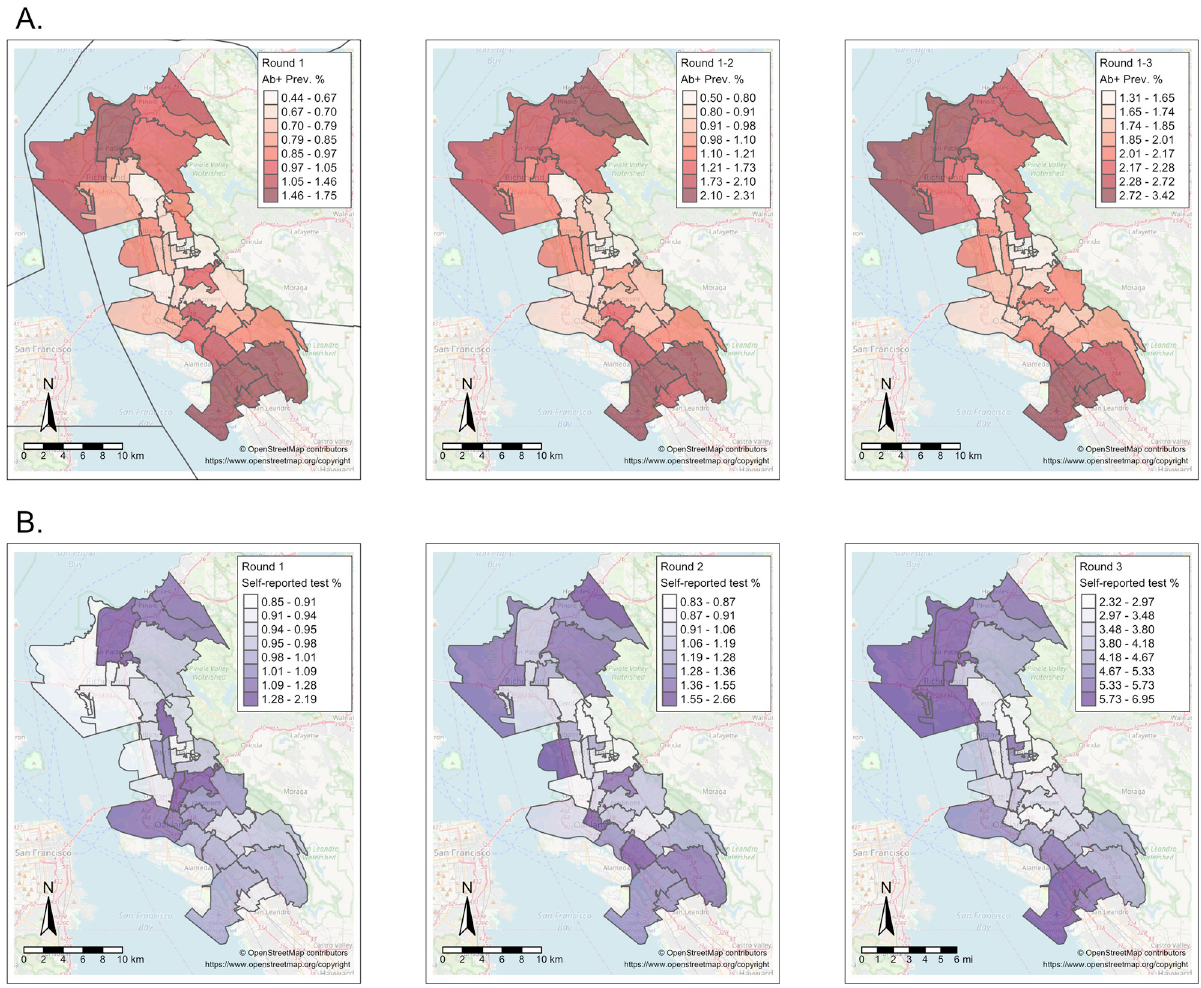
Fig 2. Population-adjusted prevalence of SARS-CoV-2 outcomes within study region ZIP codes. (A) Cumulative seroprevalence of SARS-CoV-2 antibodies to natural infection. (B) Prevalence of self-reported COVID-19 test positivity across the study region. Data collected in three rounds: